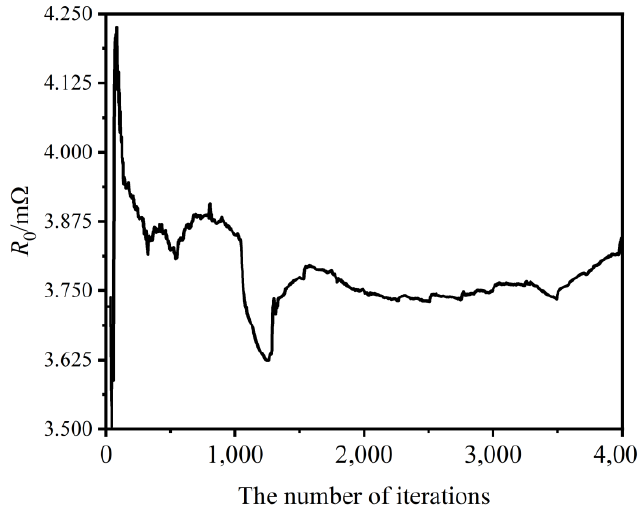
Figure 8. R 0 identification result diagram.